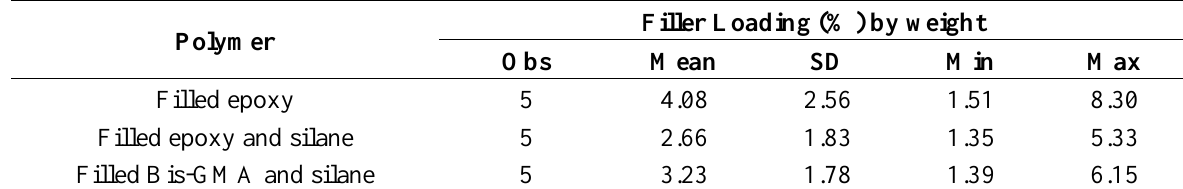
Table 3. Filler loading by weight for the filled specimens.